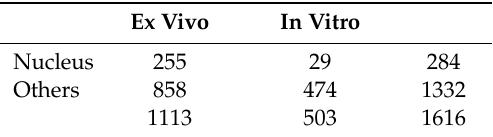
Table 2. Contingency table for the cluster